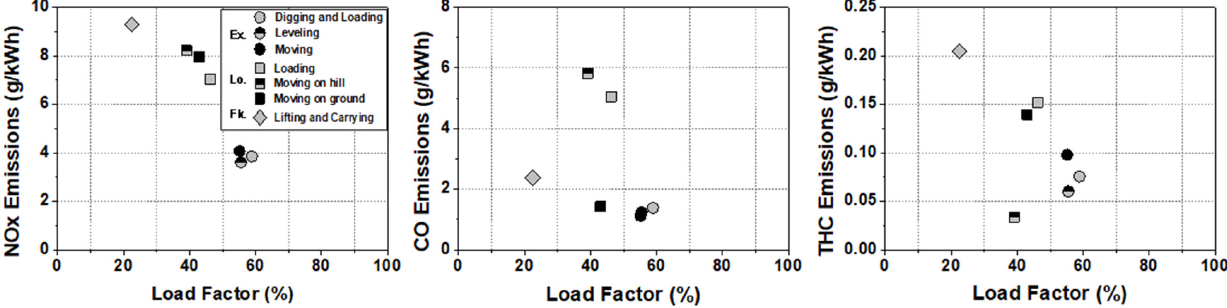
Figure 6. Average brake-specific emissions in according to load factor as real-world working modes of tested for K-tier3 construction machinery.